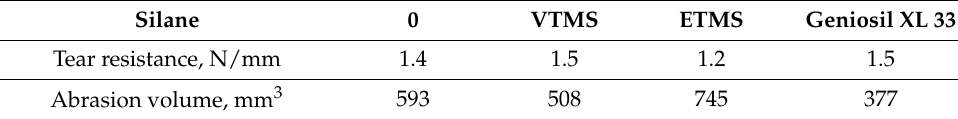
Table 4. Mechanical properties of the EPDM/CaCO 3